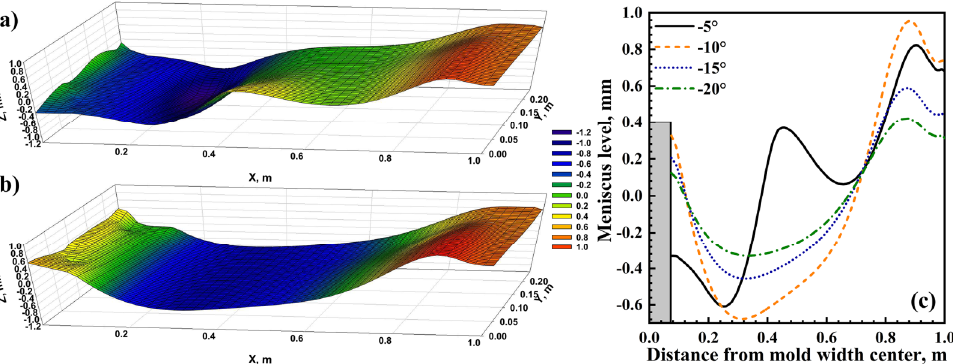
Figure 11. The calculated 3D meniscus level profile s for the cases with −5° ( a ) and −10° ( b ) port angles; and meniscus level profiles on the mid-thickness plane of the mold under different port angles ( c ).